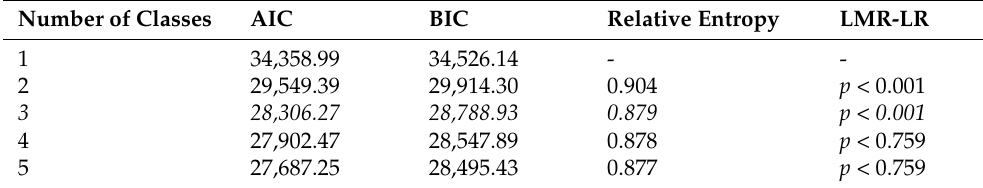
Table 3. AIC, BIC, relative entropy, and LMR-LR for 1–6 classes in the latent class